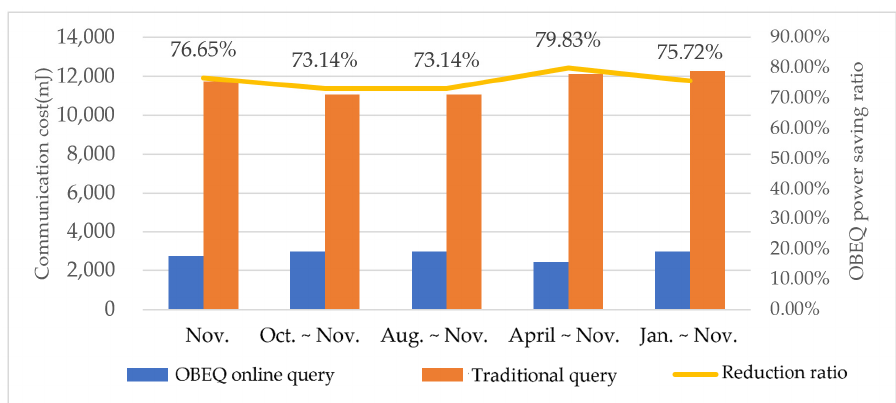
Figure 18. The power consumption of different-size training data.